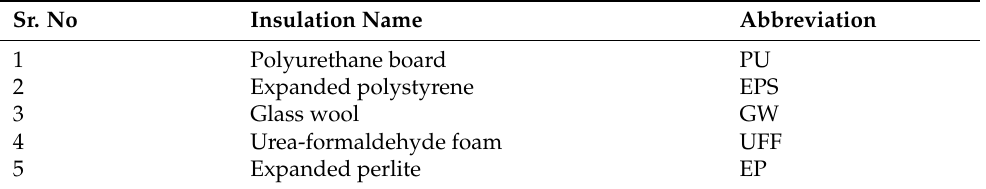
Table 1. Physical and functional properties of the building. Table 2. Type of thermal insulation with